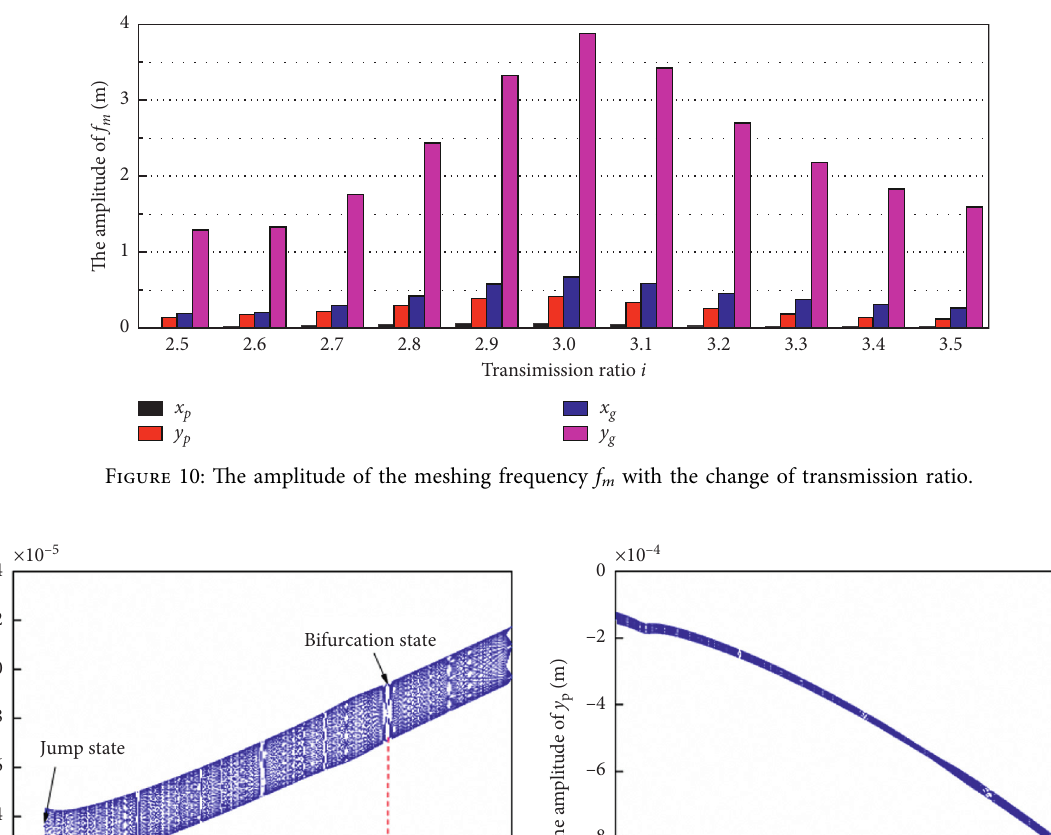
Figure 11: Bifurcation diagram of the driving gear: (a) in x direction and (b) in y